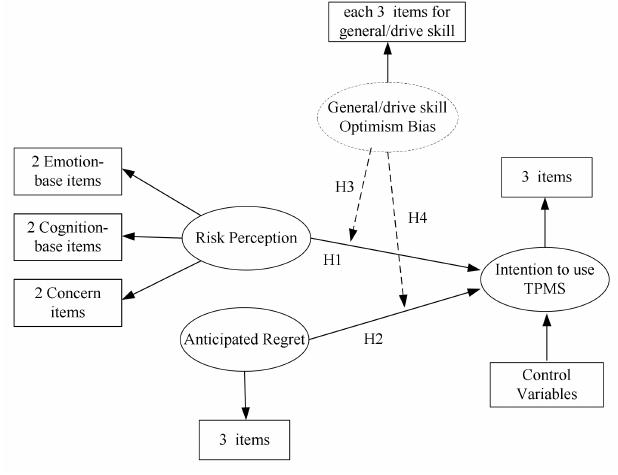
Figure 1. Conceptual